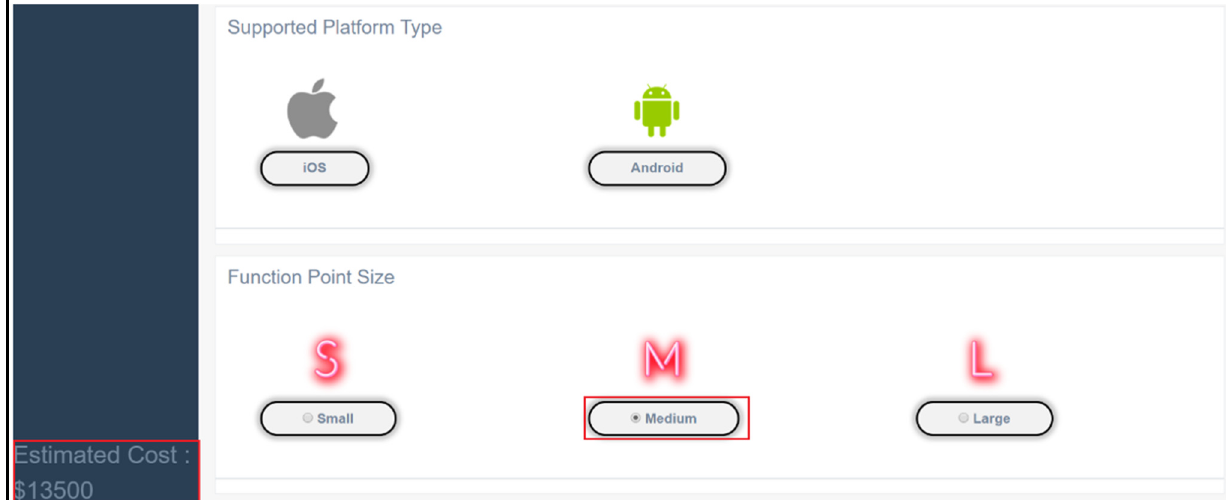
Figure 2. User interface for estimated cost.